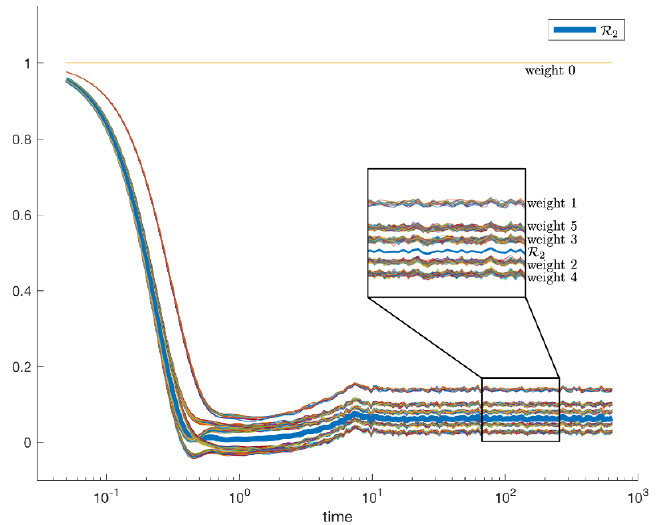
Figure 5 . The 2-point form factor and the 2-point functions h A j A j ( t ) i of Pauli operators for H RNL for n = 5 sites and averaged over 500 samples. The thick blue line is R 2 =L 2 and surrounding bands of lines are all 1024 Pauli 2-point functions of di(cid:11)erent